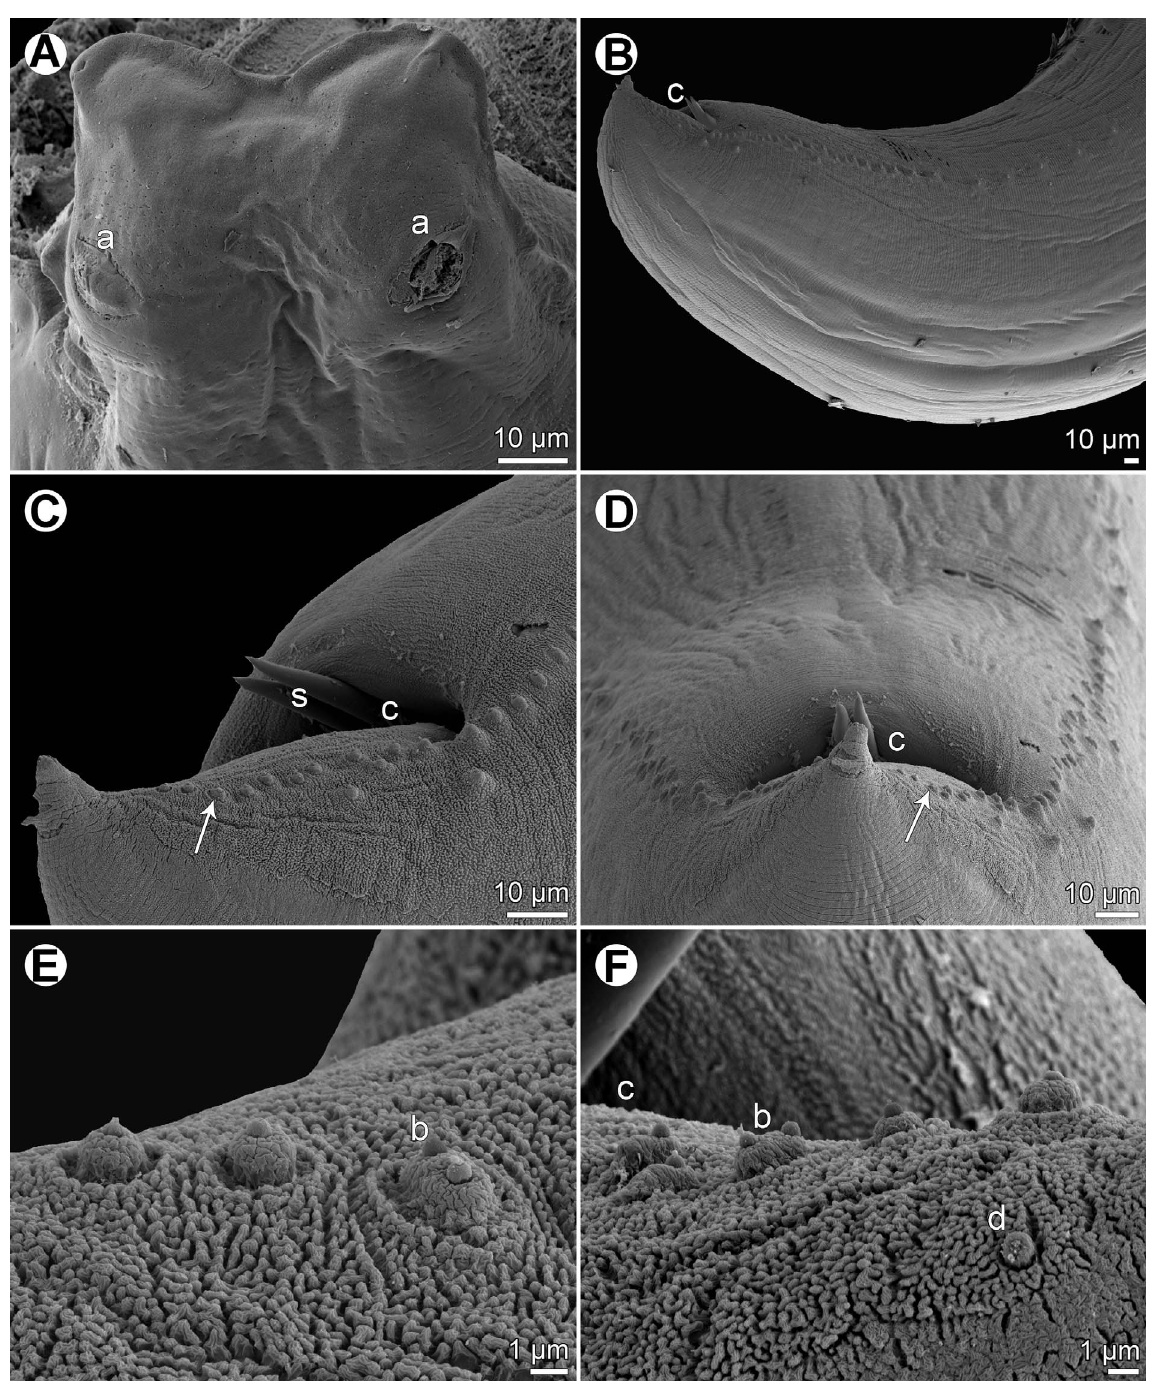
Figure 4. Raphidascaris ( Ichthyascaris ) fasciati n. sp., scanning electron micrographs of male. (A) Dorsal lip; (B) posterior end of male, lateral view; (C) tail, sublateral view (arrow indicates postanal double papilla); (D) region of cloaca and tail, dorsoventral view (arrow indicates postanal double papilla); (E) postanal papillae of three posteriormost pairs; (F) region of postanal papillae of four posteriormost pairs, lateral view. (a) Labial double papilla; (b) postanal double papilla; (c) cloacal aperture; (d) phasmid; (s)